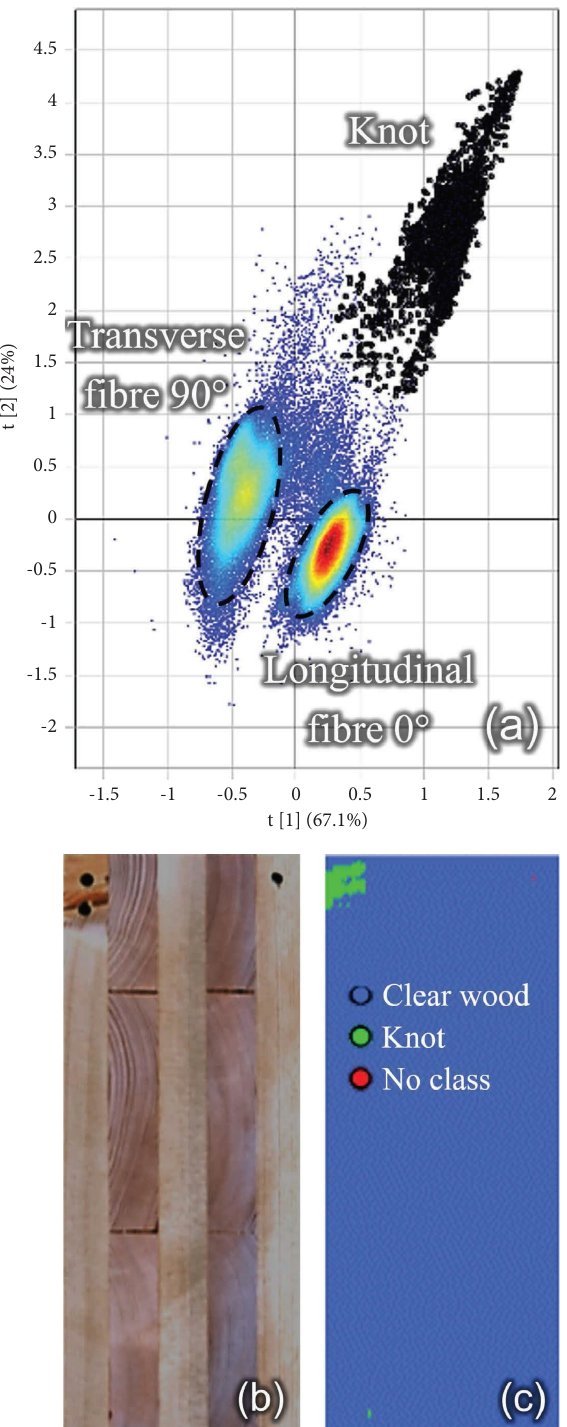
Figure 3: (a) Partial least squares discriminant analysis (PLS-DA) model scatter plot shows that the knot is separated from clear wood and transverse layers are negatively correlated to longitudinal layers, (b) predicted RGB image, and (c) a predicted